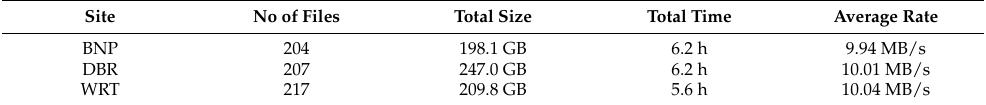
Table 5. Download summary.